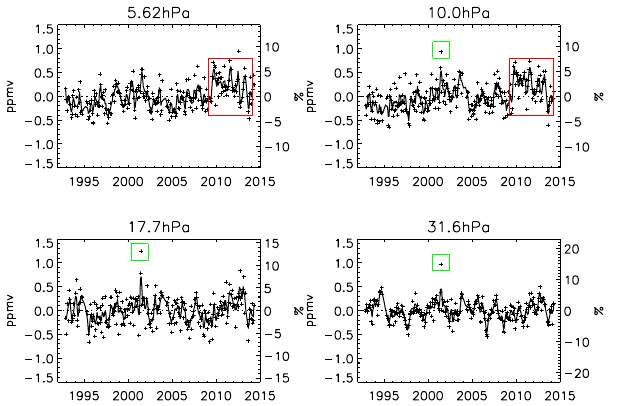
Figure 3. Crosses show monthly ozone anomalies from the MOPI1 measurements. The line shows a 3-point smoothing of the data. Boxes indicate periods of particular interest (see text).